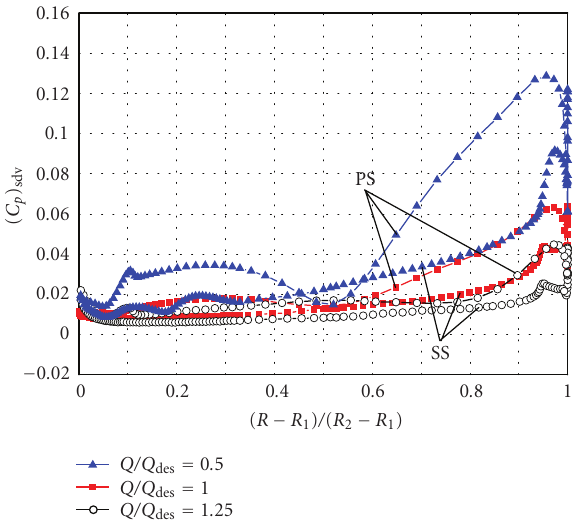
Figure 7: Comparison of pressure fluctuation on the impeller blade, midspan.